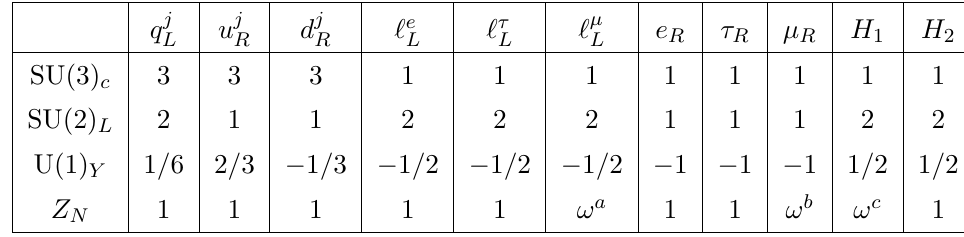
Table 3 . The matter contents and the charge assignments. Here ! = exp(2 (cid:25)i=N ). It is possible to obtain realistic neutrino masses and the PMNS matrix from eq.